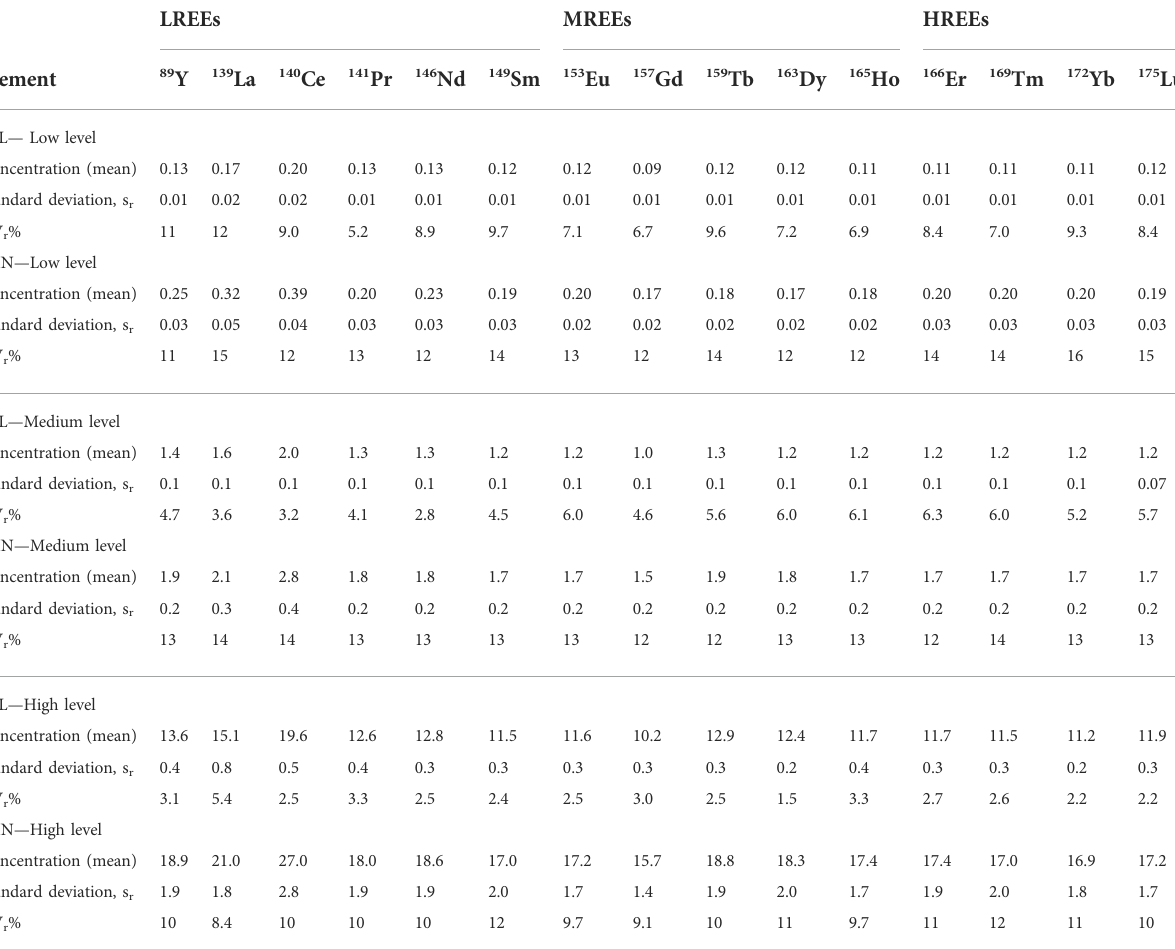
TABLE 4 Results of repeatability precision expressed as standard deviation, s r (µg/L) and relative standard deviation (CV r %) at three different levels of concentrations for the dilution (DIL) and digestion (MIN) sample preparation procedures. LREEs MREEs HREEs